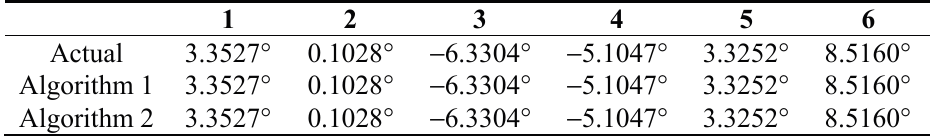
Table 11. Alignment results of the six simulations